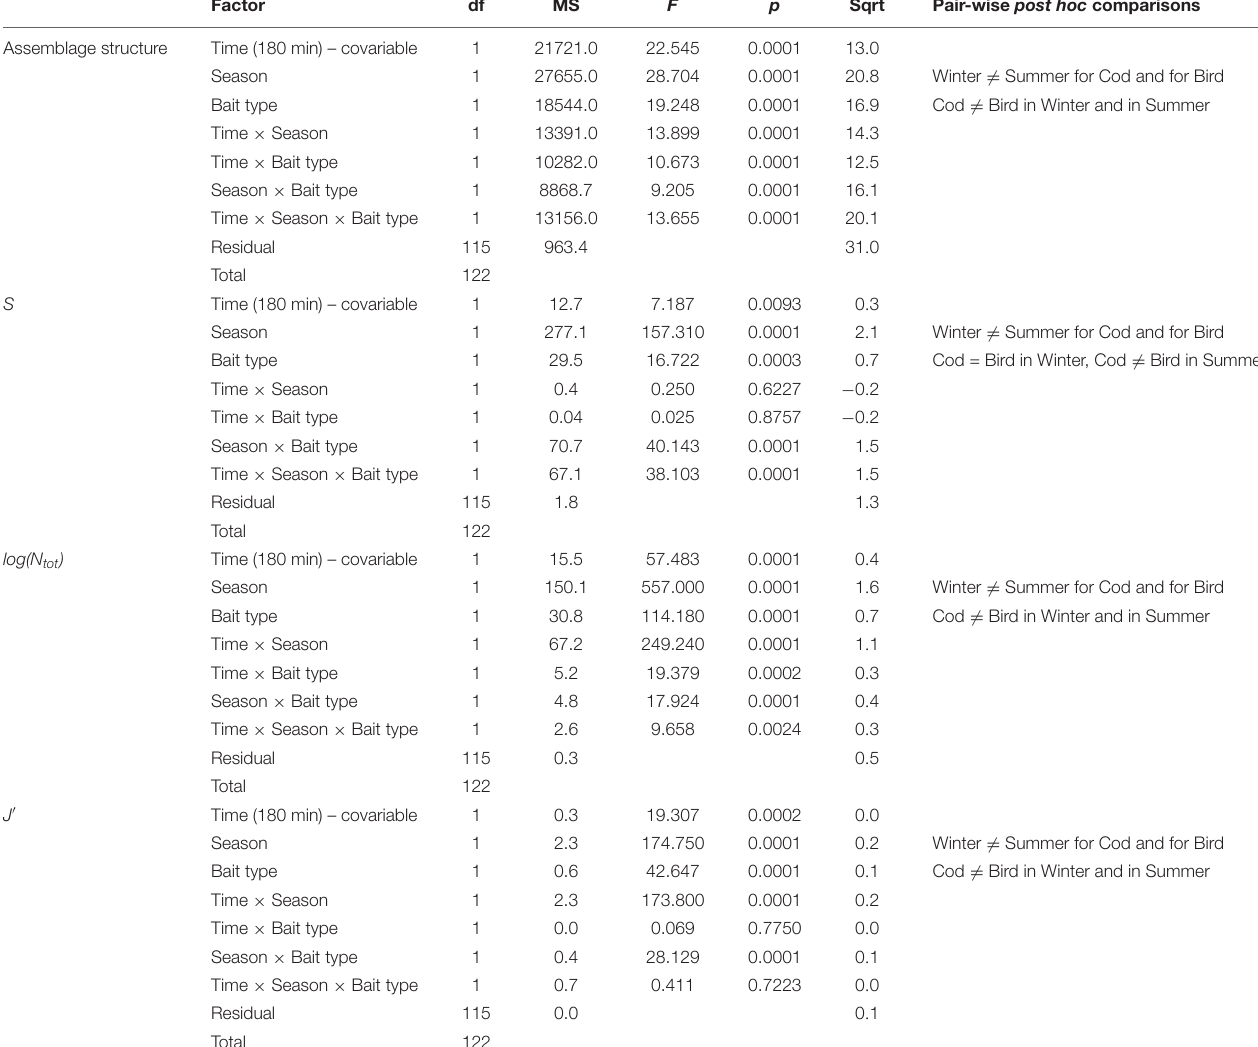
TABLE 3 | Results of multivariate and univariate PERMANOVA analyses for differences in scavenger assemblages through time (as a linear covariate) and between seasons and bait types. Factor df MS F p Sqrt Pair-wise post hoc comparisons Assemblage